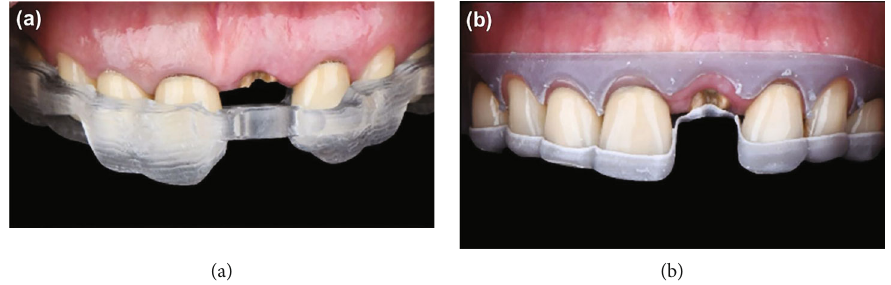
Figure 4: Try-in of implant surgical guide (a) and crown lengthening guide (b).